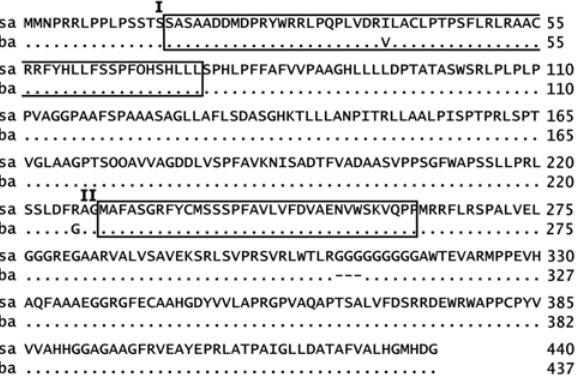
Fig 5. APO1 amino acid sequences in Sasanishiki and Habataki. Boxes show predicted functional motifs (I, F-box domain; II, Kelch motif). APO1 of Habataki has two amino acid substitutions (Ile39Val in the F- box domain and Arg226Gly near the Kelch motif), and a deletion of three amino acids (Gly309 – Gly311) in comparison with Sasanishiki. Sasa, Sasanishiki; Haba,